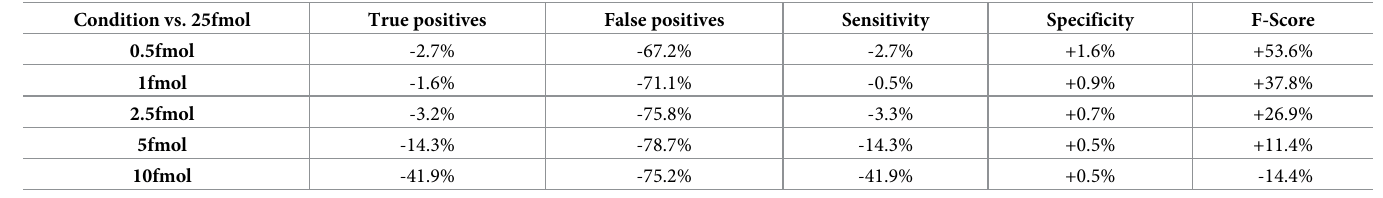
Table 3. Performance of the mi4p methodology expressed in percentage with respect to DAPAR workflow, on Saccharomyces cerevisiae + UPS1 experiment, with Match Between Runs and at least 1 out of 3 quantified values in each condition. Missing values (6%) were imputed using the maximum likelihood estimation method. Condition vs.